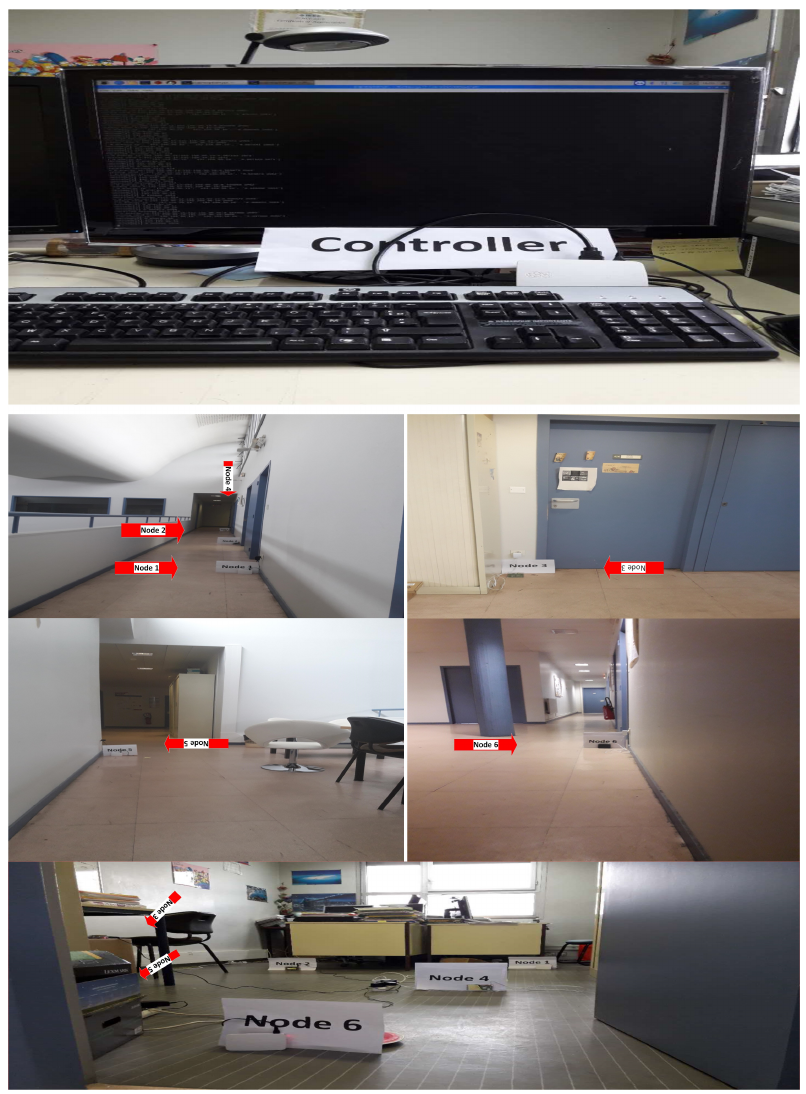
Figure 9. Real-time nodes deployment on the fourth floor of IRIT-1